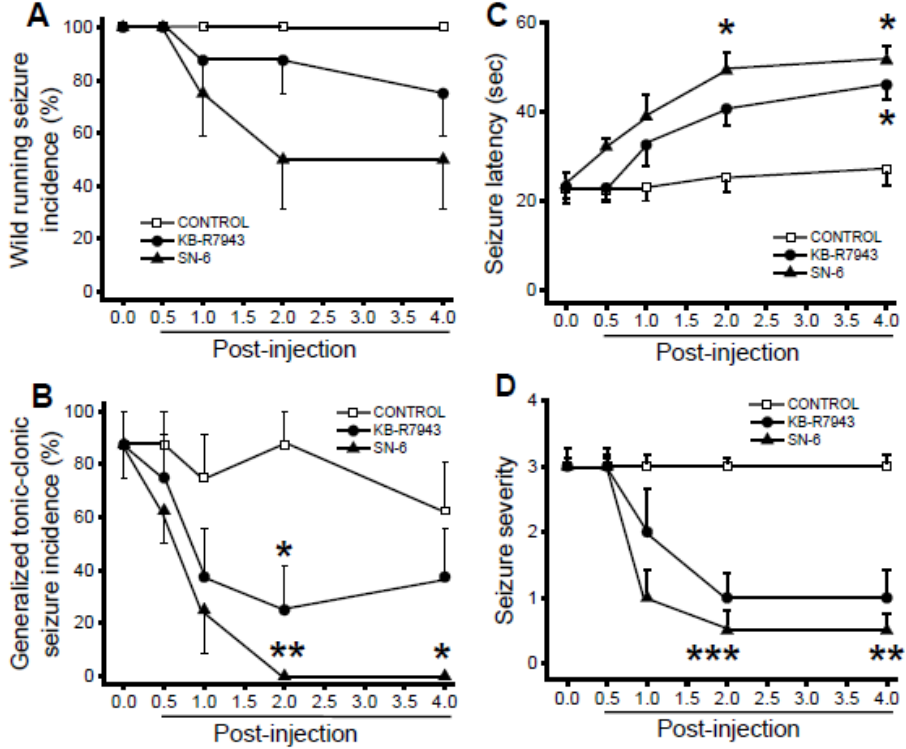
Figure 4. Effects of acute SN-6 or KB-R7943 treatment at the dose of 10 mg/kg on the occurrence of acoustically evoked AWS susceptibility. The putative seizure suppressive effects of the inhibitor NCX1 rev (SN-6, 10 mg/kg, p.o.) and NCX3 rev (KB-R7943, 10 mg/kg, p.o.) were evaluated in rats exhibiting AWSs. ( A ). Both SN-6 and KB-R7943 treatments did not considerably reduce the incidence of WRSs component of AWSs. ( B ). SN-6 and KB-R7943 treatment completely suppressed and reduced the occurrence of GTCSs component of AWSs, respectively, by the 2nd h post injection. ( C ). SN-6 and KB-7943 treatment delayed the onset of AWS by the 2nd and 4th h posttreatment, respectively. ( D ). SN-6 (but not KB-R7843) significantly reduced the AWSs severity. Data from the incidence of WRSs and GTCSs, seizure latency, and seizure severity are presented and analyzed as described in Figure 2. The summary of data was obtained from eight rats per group. * p < 0.05, ** p < 0.01, *** p <